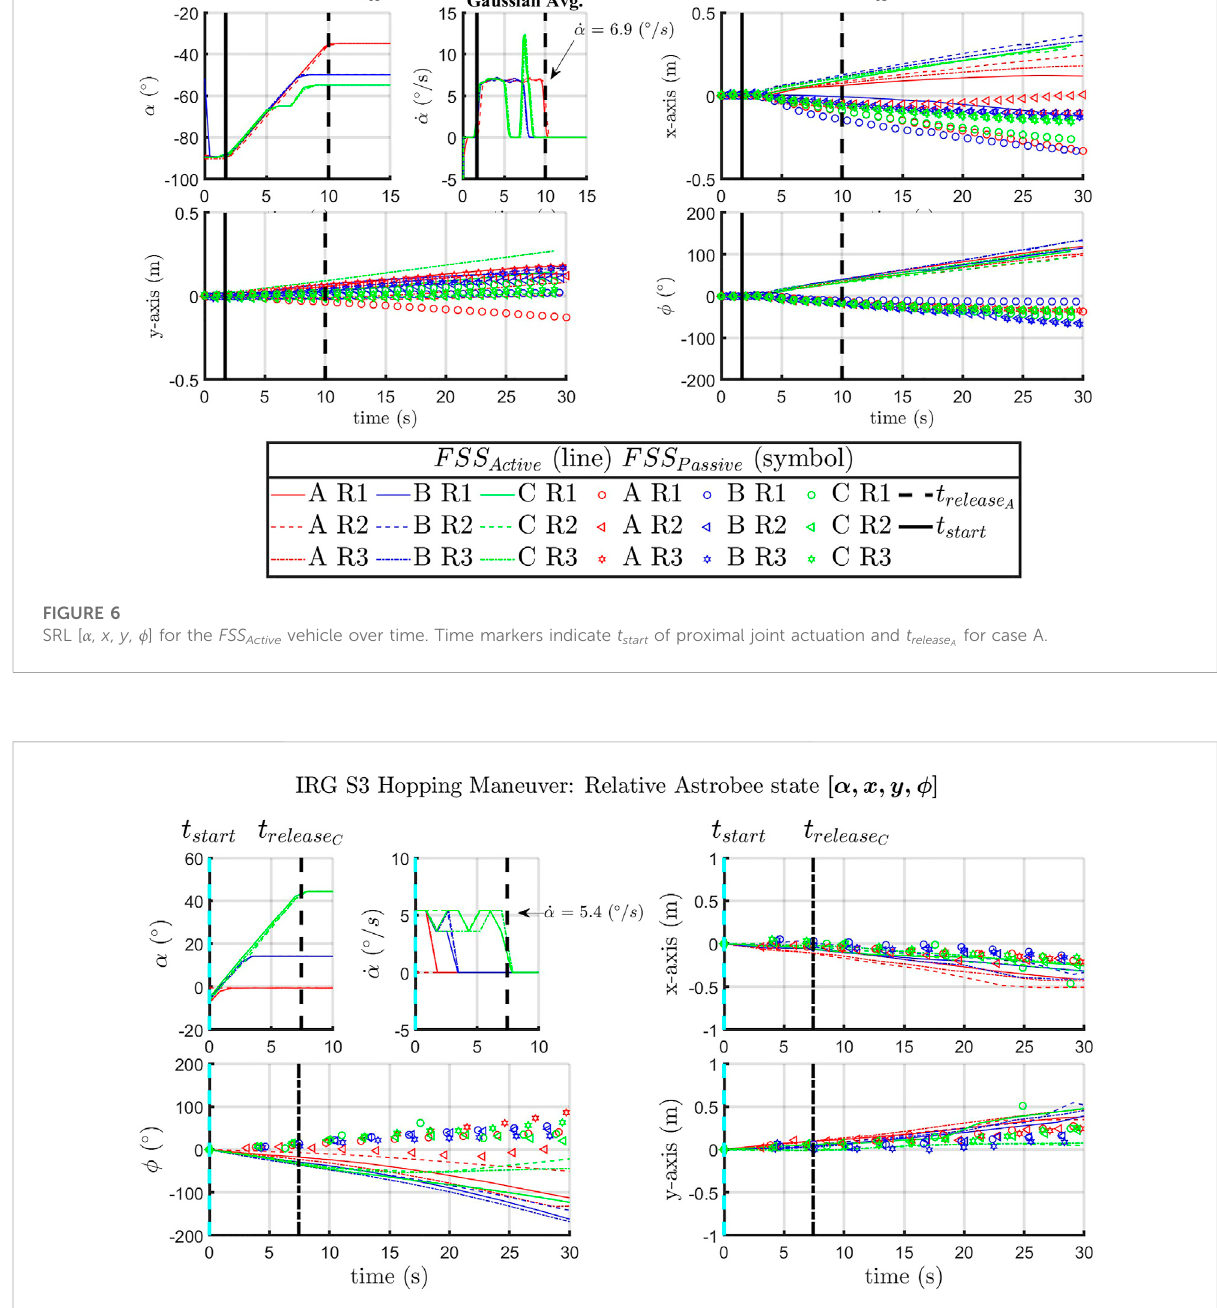
Frontiers in Robotics and